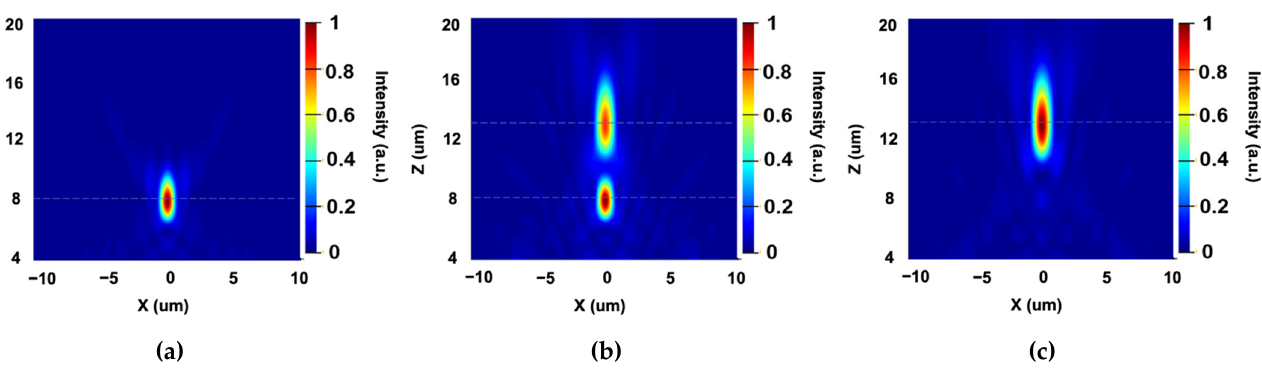
Figure 5. Simulated performance of the polarization-dependent bifocal metalens. ( a – c ) The intensity profile of the transmitted light field in the x–z plane when RCP, LP and LCP are incident.